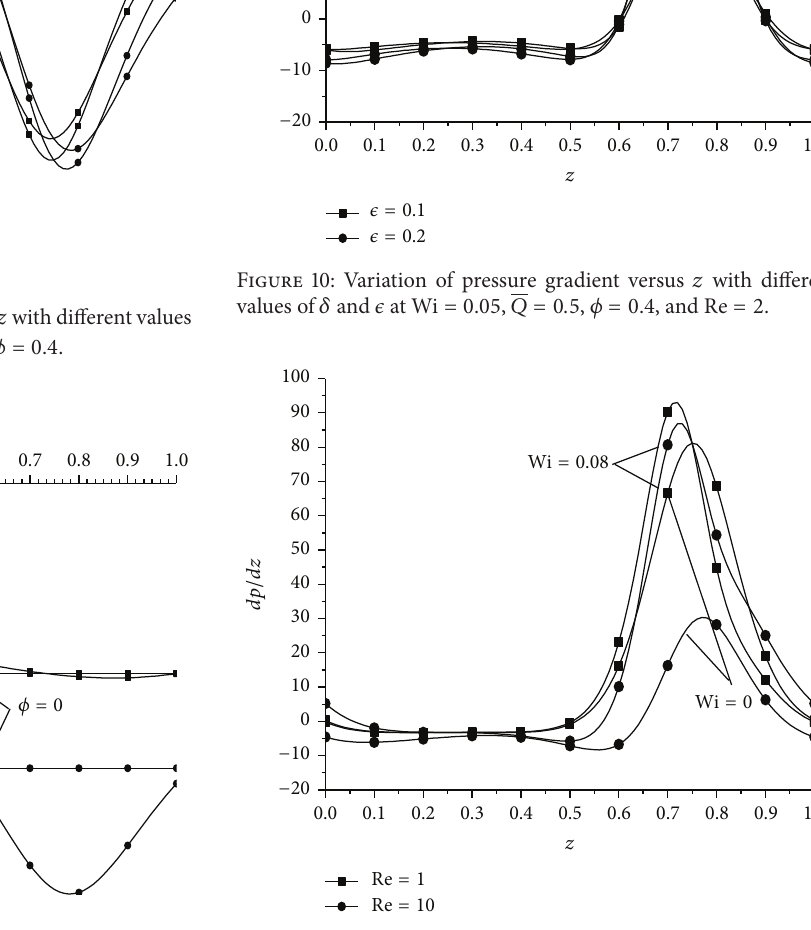
Figure 11: Variation of pressure gradient versus 𝑧 with different values of Wi and Re at 𝛿 = 0.1 , 𝑄 = 0.1 , 𝜙 = 0.4 , and 𝜖 = 0.1 . of the Weissenberg number Wi along the annulus. The inverse results are seen through Figures 15 and 16 for the shear stress at the inner